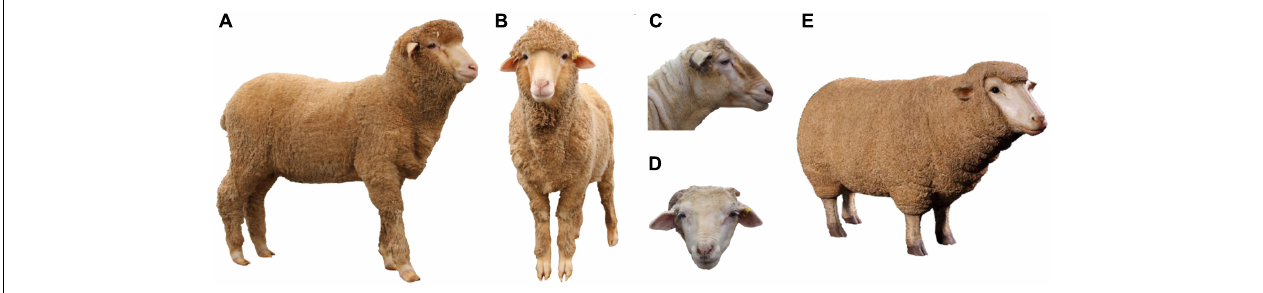
FIGURE 2 | Alternative stimuli trialed during the pilot study. Stimuli included photographs of entire sheep from the side (A) and front (B) , photographs of faces only from the side (C) and front (D) and a three-dimensional fiberglass model of a sheep (E) . All stimuli were approximately life-size.